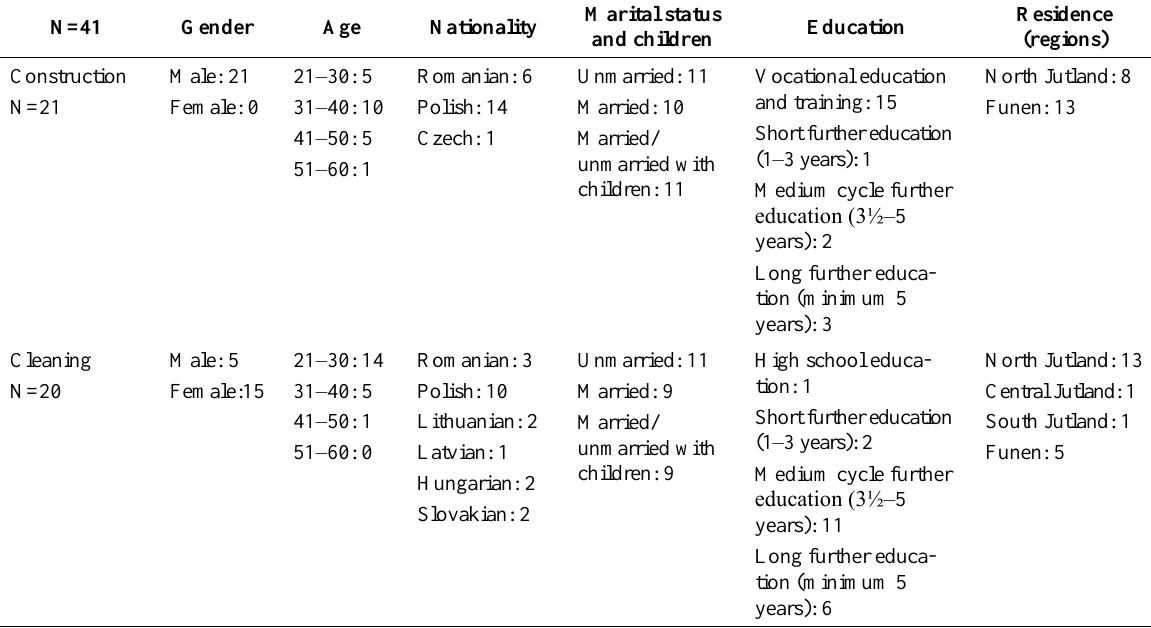
Table 1. Outline of the interviewed individuals